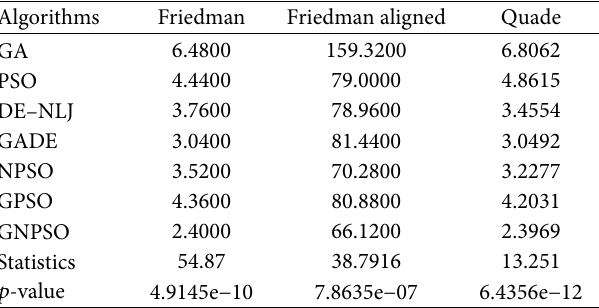
Figure 4: Comparison of convergence process of the best fitness for linear wing vibration